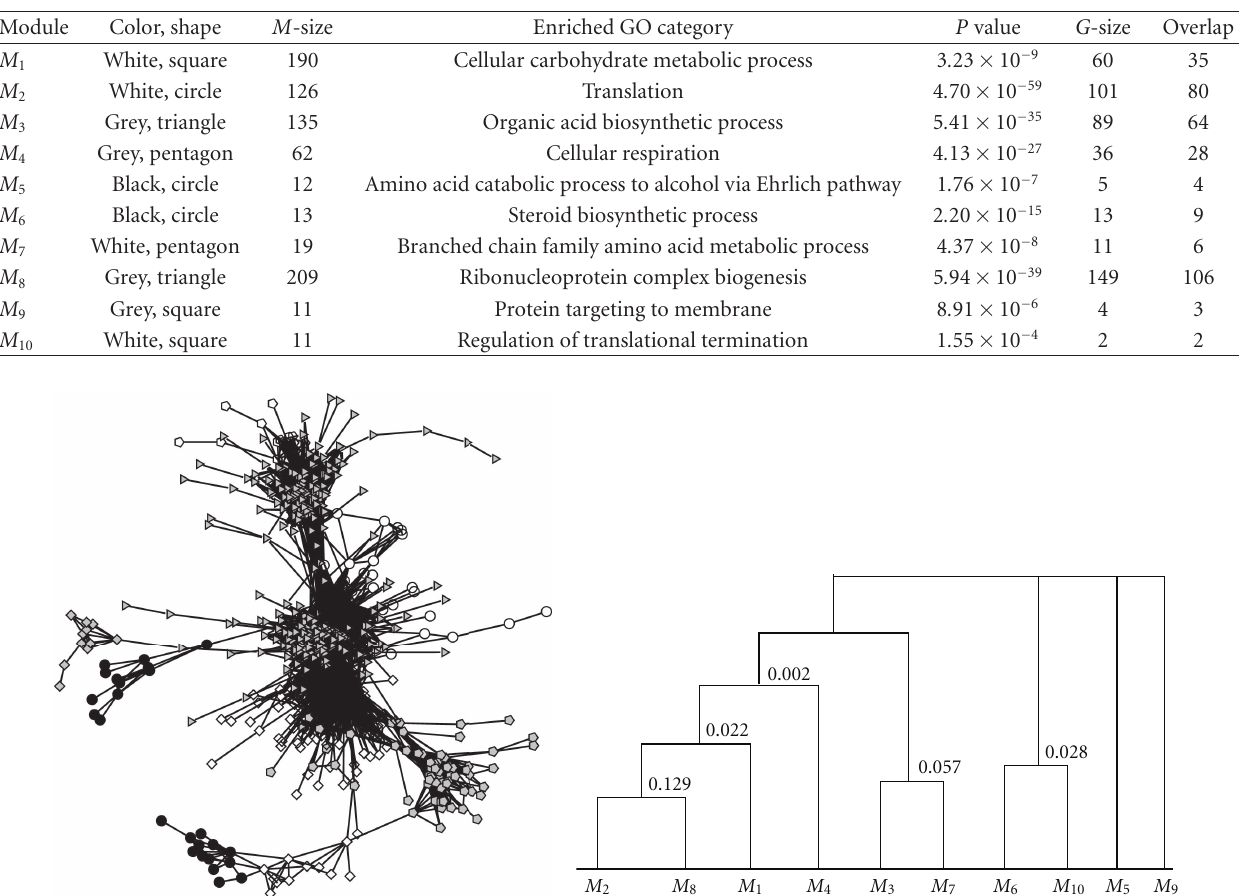
Table 1: GO enrichment analysis results of the gene modules on the lowest level.